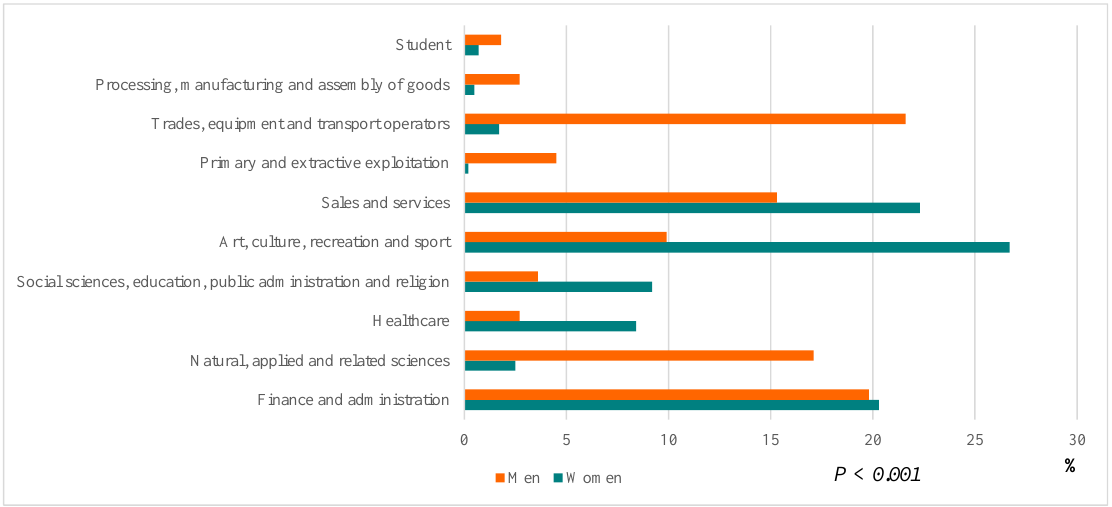
Figure 2. Classification of patients by occupation and gender.